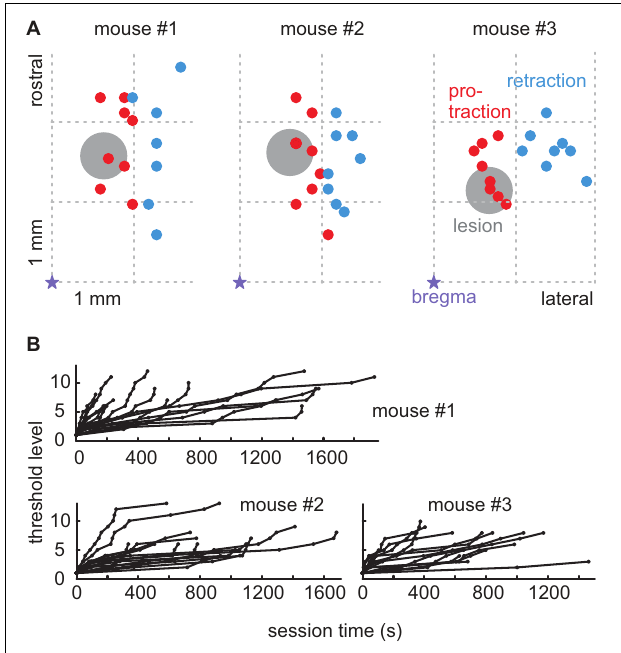
FIGURE 3 | Rhythmic whisking (RW) lesions. (A) The location of minimal lesions within the functional map of the right hemisphere whisker motor cortex for three mice. The violet star is bregma; right is lateral; up is rostral; and the grid indicates the location in anterior-lateral coordinates. The colored dots are the locations of successful microstimulation evoking protraction (red) and retraction (blue whisker movements). Lesions (diameter about 0.5 mm, gray circle) were done with a micro-suction pipette. They were located within RW (red) but in the vicinity of RF (blue). (B) Progression of threshold levels in all post-lesion sessions in all three mice (conventions as in Figure 1D